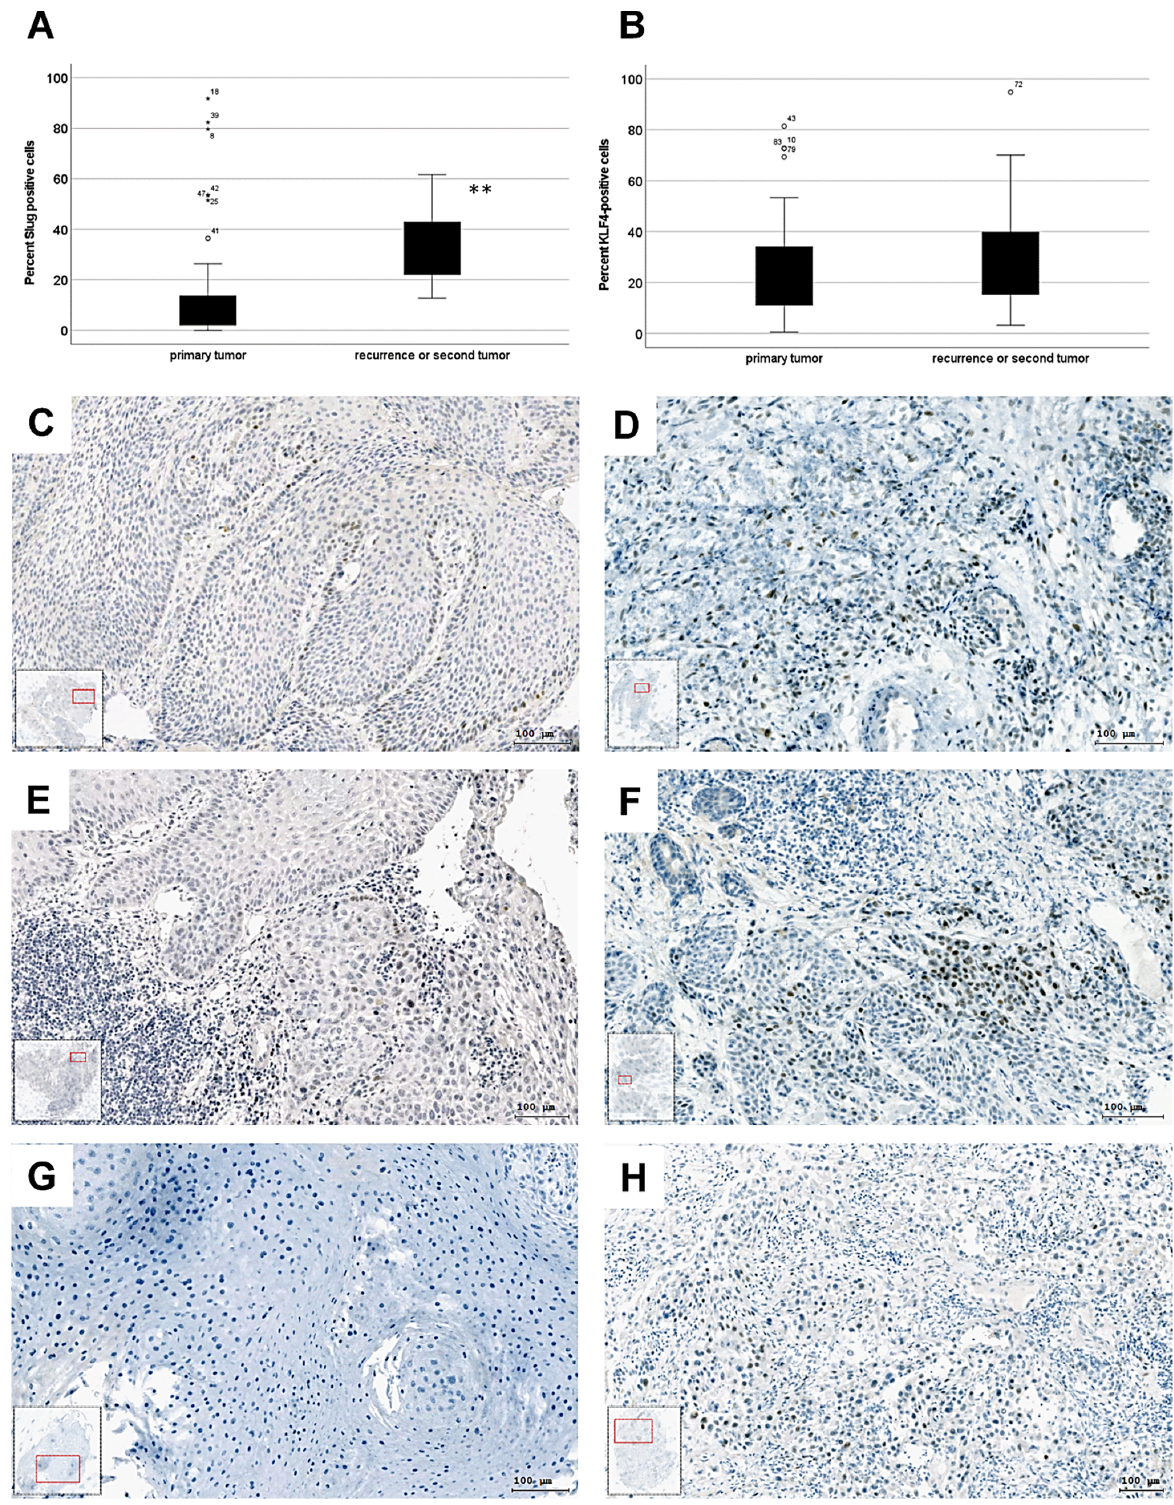
Figure 1. Boxplot presentation of the percentage of ( A ) Slug-positive ( B ) KLF4-positive cells with immunohistochemistry in 58 primary tumor and 14 recurrence or secondary tumor samples, (**: p = 0.007 with Mann–Whitney U test, KLF4-graph; p = 0.5). **: less than 0.01. ( C ) Slug + immunohistochemical reaction in the leading edge of the cancer cell nests in HPV-negative primary oropharynx squamous cell carcinoma. ( D ) Diffuse and increased Slug + immunohistochemical